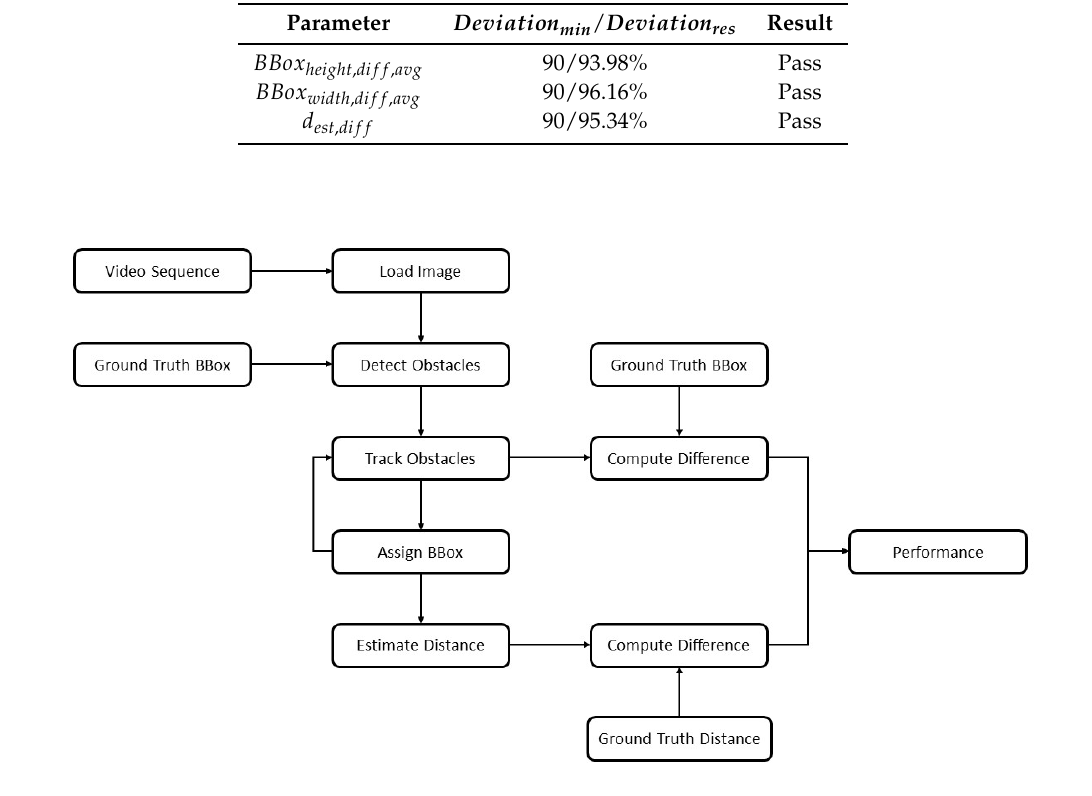
Figure 5. System environmental perception evaluation